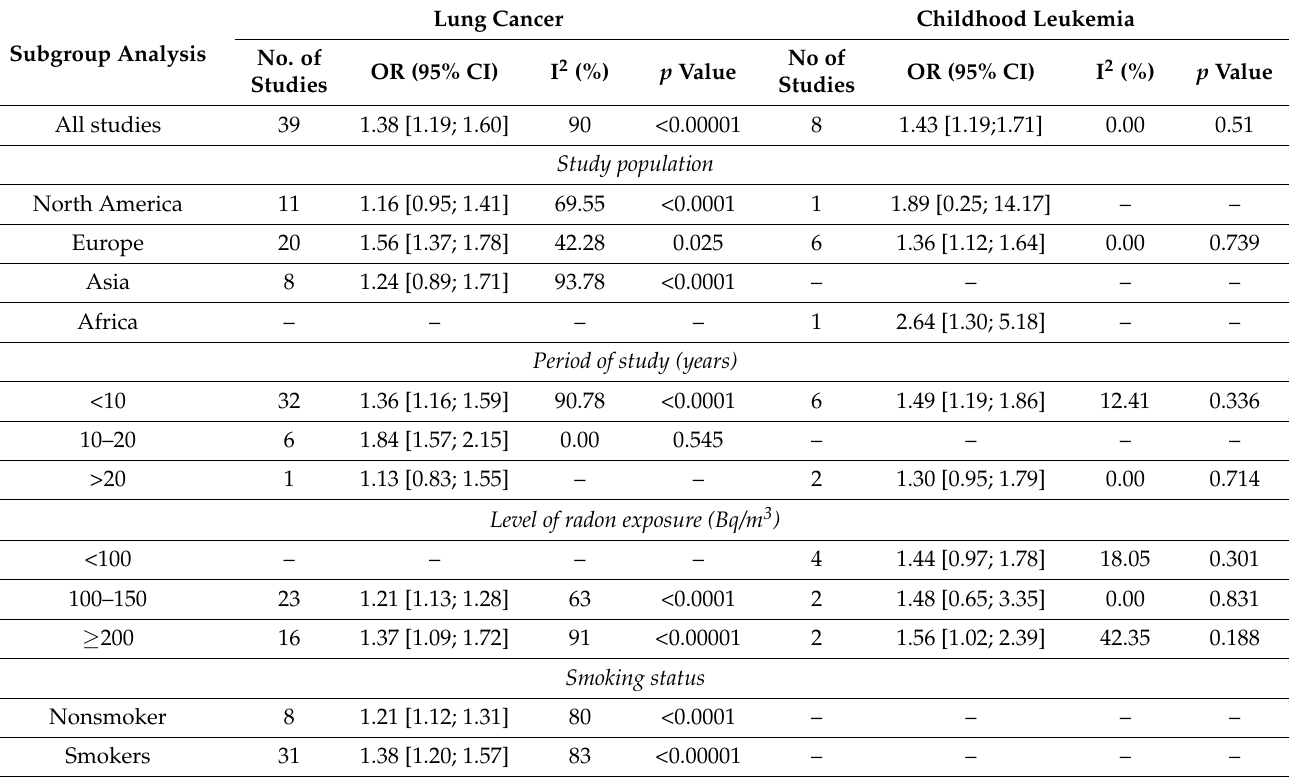
Table 3. Pooled estimated size effects (95% CI) regarding subgroupanalysis of case–control